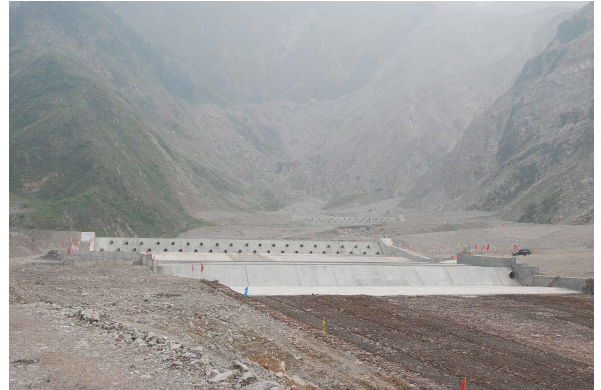
Fig. 20. Drainage system constructed in the upstream part of the Wenjia gully.